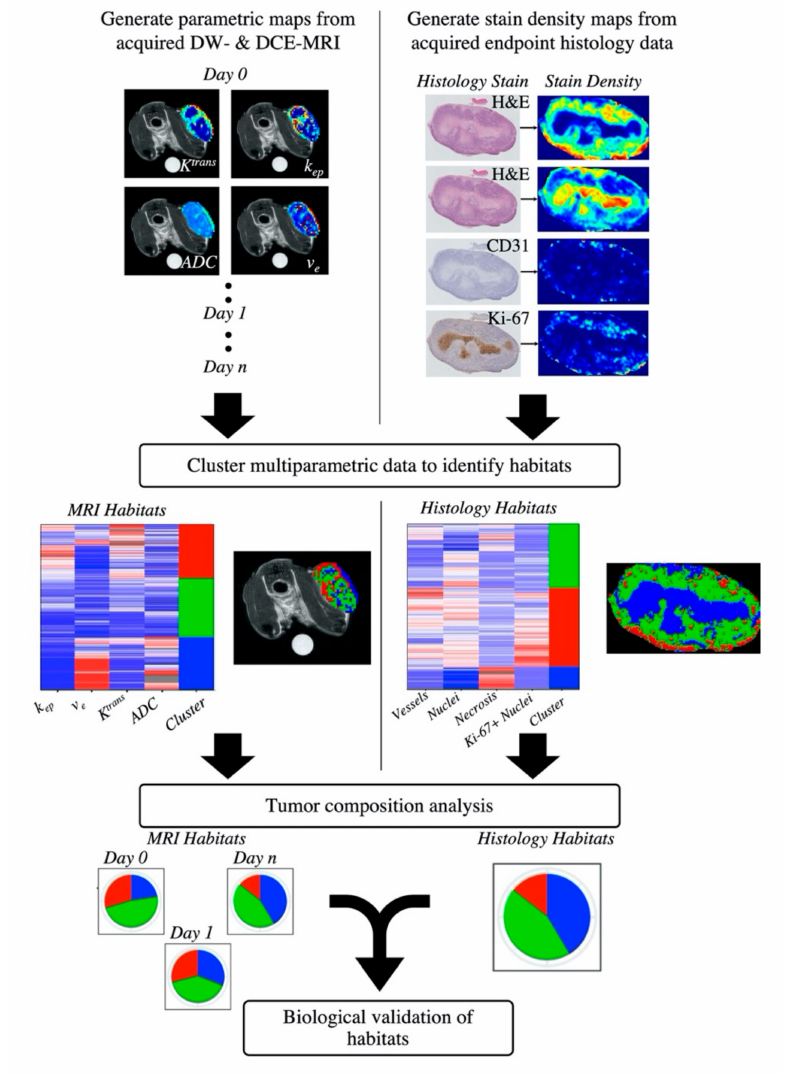
Figure 1. Pipeline for the habitat imaging analysis. Longitudinal DCE- and DW-MRI data was acquired for each animal and processed to generate individual multi-parametric maps of the tumor region (top row, left). Each tumor voxel was then defined as a vector where each element corresponded to one of the parameters returned from the quantitative MRI analysis. Voxel data within each individual tumor cohort (BT-474 or MDA-MB-231) were pooled together. The pooled voxel data is then clustered to identify tumor habitats (middle row, left). Tumor composition over time was quantified in terms of the percent of each tumor’s volume having a particular habitat (bottom row, left). End point histology data was acquired and processed to generate stain density maps (top row, right). Each pixel was then defined as a vector of its stain density values and pixel data within each tumor cohort were pooled together. The pooled pixel data is clustered to identify histological tumor habitats (middle row, right). Histological tumor composition was then quantified in terms of the percent of each tumor’s area having a particular habitat (bottom row, right). To biologically validate imaging-derived habitats, a correlation analysis was performed between habitat percent tumor volume from the imaging-derived habitats, and habitat percent tumor area from the histology-derived